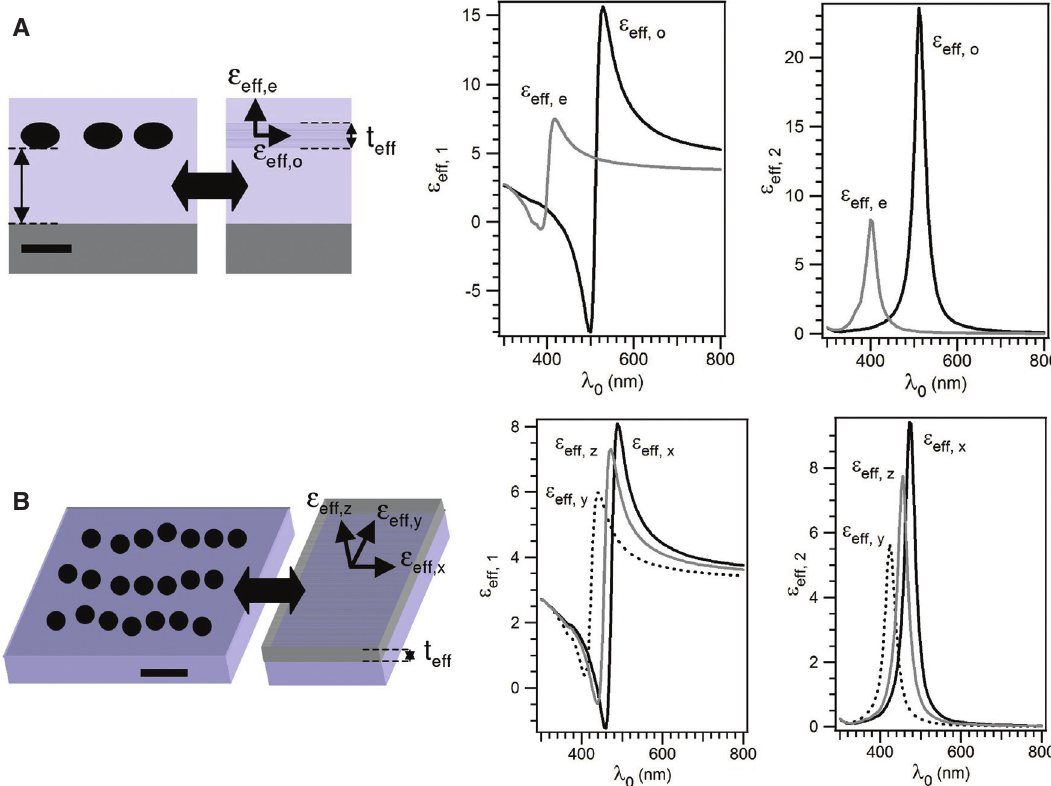
Figure 7 Examples of plasmonic metamaterials described in the Abélès matrix formalism using the effective medium approximation. Sche- matic representation of (A) a 2D assembly of NPs embedded in a dielectric matrix (seen in cross-section); (B) Planar assembly of 1D arrays of aligned NPs on a substrate. Typical order-of-magnitude scale bars are also shown: 10 nm for (A), 20 nm for (B). Their effective counterparts are also depicted, together with the parameters (dielectric functions, effective thickness t Effective medium simulations of the real and imaginary part of the corresponding dielectric functions are also shown in each case. In (A), the simulations have been done using the Yamaguchi theory, assuming oblate spheroidal Ag NPs with a vertical revolution axis (with the bulk silver dielectric function taken from the Palik database) embedded in a-Al H/D = 0.5, diameter D = 10 nm, interparticle distance L = 20 nm. In (B), the simulations have been done using a biaxial extension of the Yama- guchi theory, for spherical Ag NPs (D = 10 nm) distributed in a plane and embedded in a-Al = 50 nm between the 1D arrays of the aligned NPs and L y